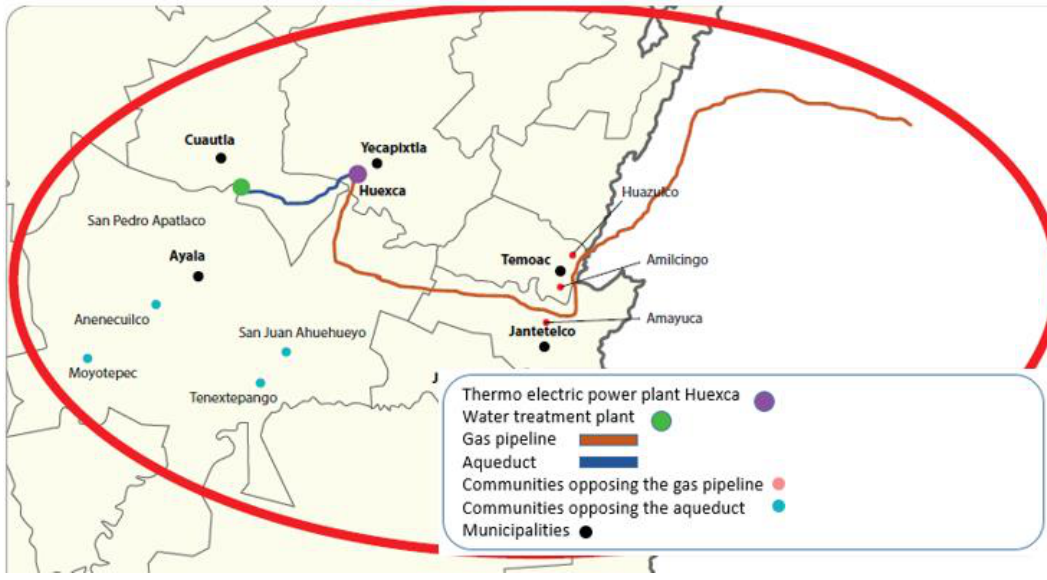
Figure 3. Opposition to the Morelos Integral Project (PIM). Source: own elaboration based on La Jornada [76].